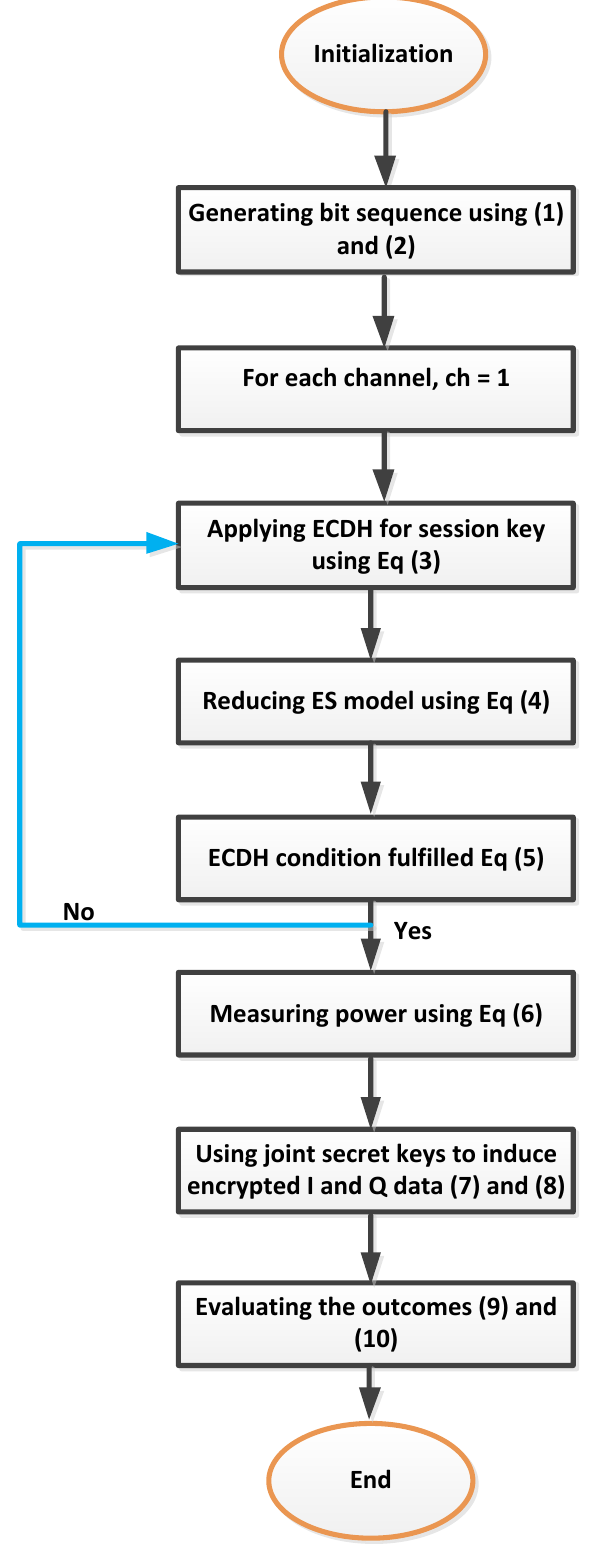
Figure 3. The description of flowchart for evaluating the physics behind the mathematical model and simulation